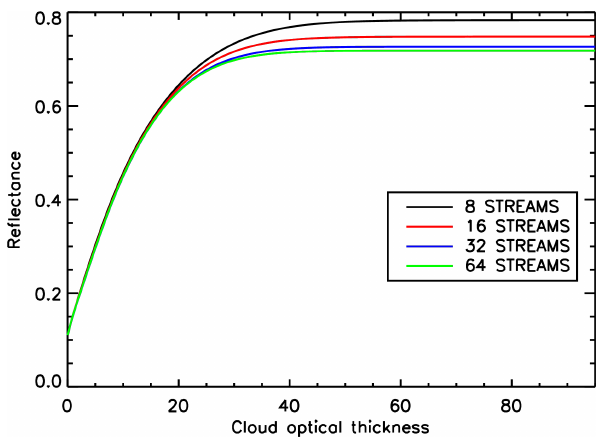
Figure 1. Dependence of simulated TOA reflectance at 443.9nm on the number of streams used in the radiative transfer